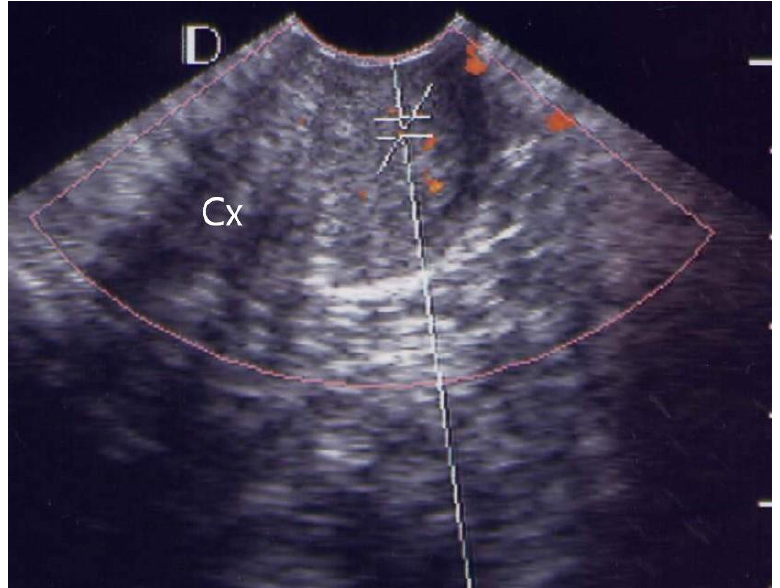
Figure 1. GRADE 1 . A case of 46 years old female with pelvic inflammatory disease, less than 5 Diagnostics 2022 , 12 , x FOR PEER REVIEW Figure 1. GRADE 1. A case of 46 years old female with pelvic inflammatory disease, less than vascular spots (orange color) in the image of cervix. (Cx: Cervix). 5 vascular spots (orange color) in the image of cervix. (Cx: Cervix).